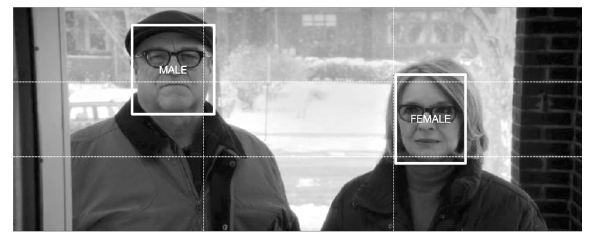
Fig. 7 Illustration of how we appraise on-screen gender placement. Bounding boxes identify face positions while white vertical/horizontal lines indicate how the frame is split according to the rule of